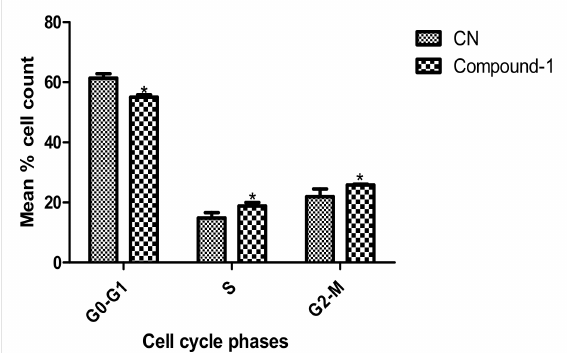
Figure 4. E ff ect of compound 1 on cell cycle of T. brucei subsp. brucei . The bar graph was plotted from the dot distributions in the cell cycle assay. P -values were calculated from four distinct counts [n = 4; p ≤ 0.05 (*, significant); p > 0.05 (not significant)]. Error bars originate from mean percentage count ± standard deviation of the mean (mean ± SD). CN is Negative